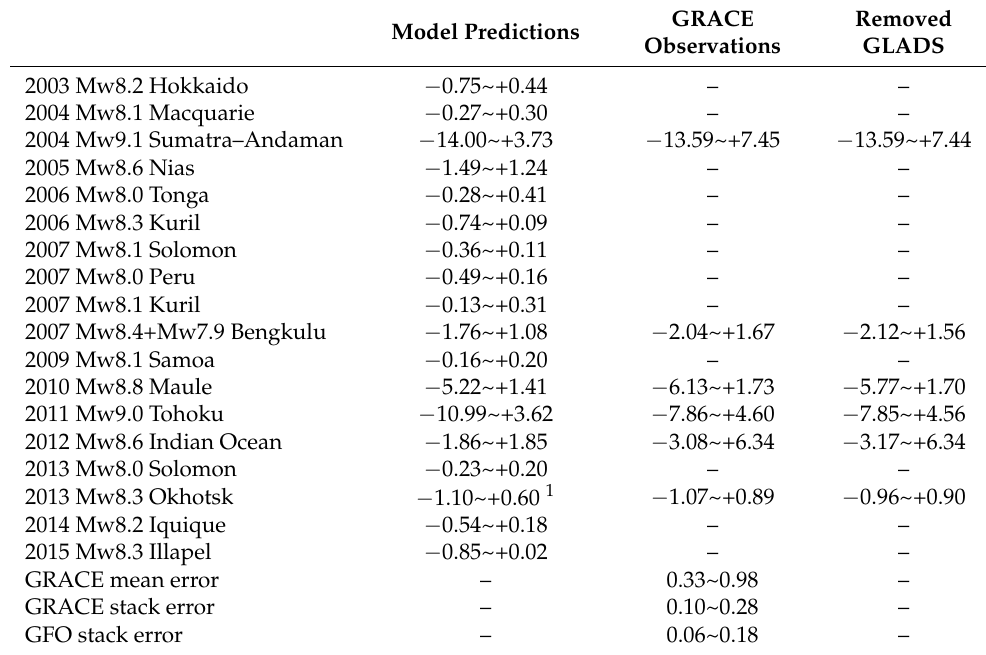
Table 1. Statistics of the model-predicted and GRACE-observed coseismic gravity changes of earth- quakes above Mw8.0 during GRACE mission and monthly model errors (unit: µ Gal).